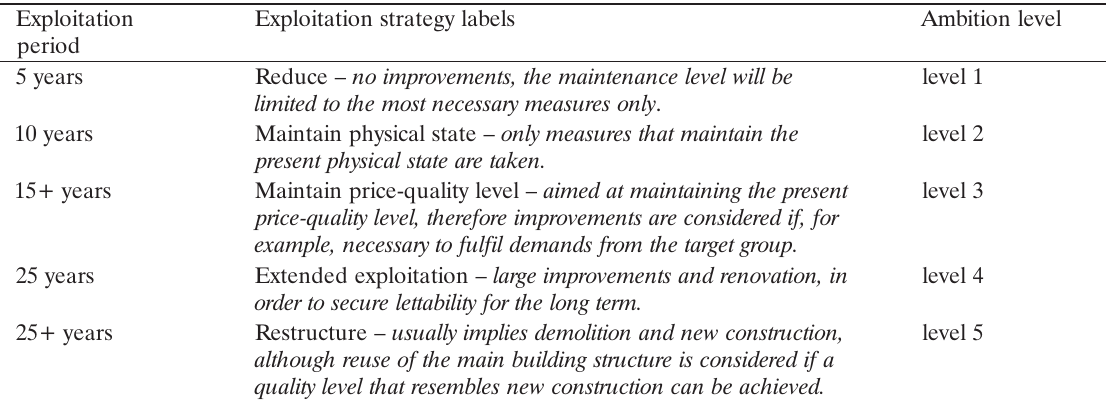
Table 4. The relation between exploitations period, exploitation strategy and ambition level of housing association